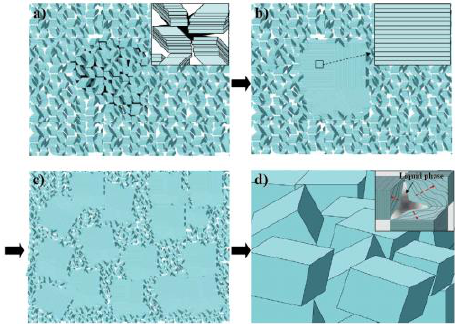
Figure 4. Schematic diagrams of sintering model as a function of temperature in KNLN-BT based ceramics.